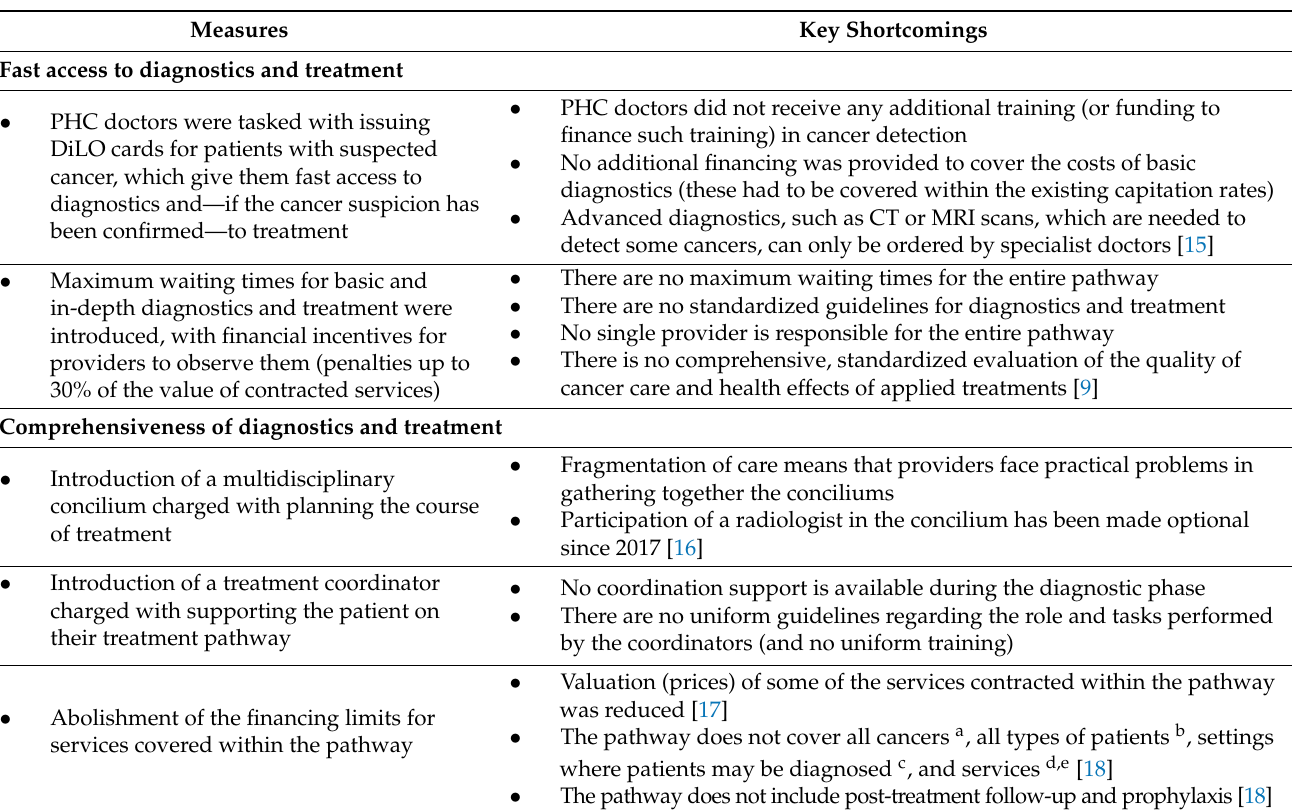
Table 1. Key measures introduced in the fast oncology pathway and their main